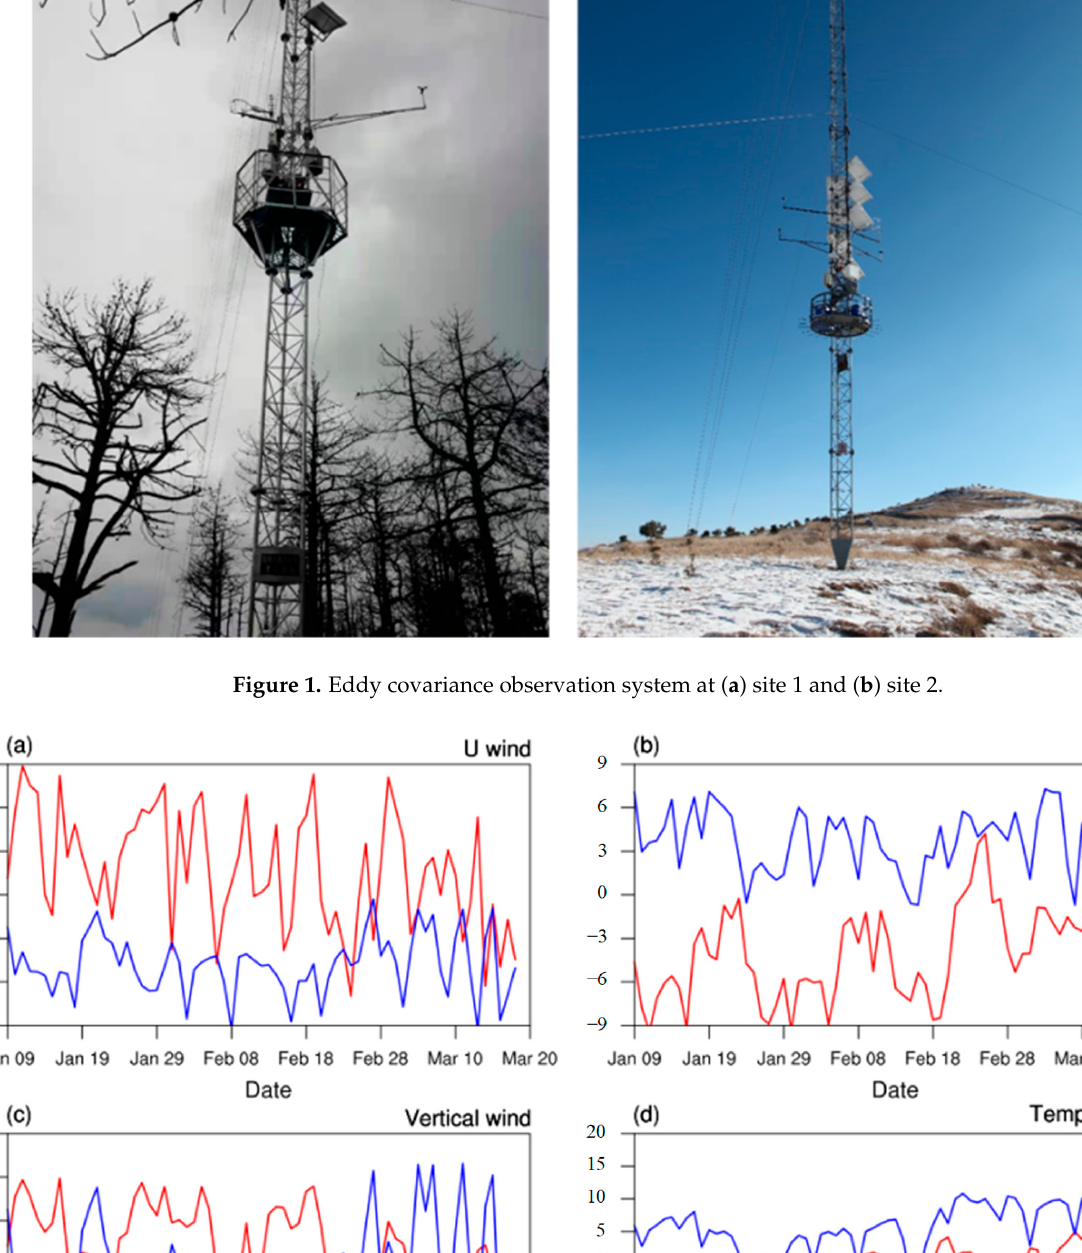
Figure 2. Eddy covariance observation data. ( a ) U wind (unit: m s − 1 ), ( b ) V wind (unit: unit: m s − 1 ), ( c ) vertical wind (unit: m s − 1 ), and ( d ) temperature ( ◦ C). Blue line is observed at site 1. The red line is observed at site 2.